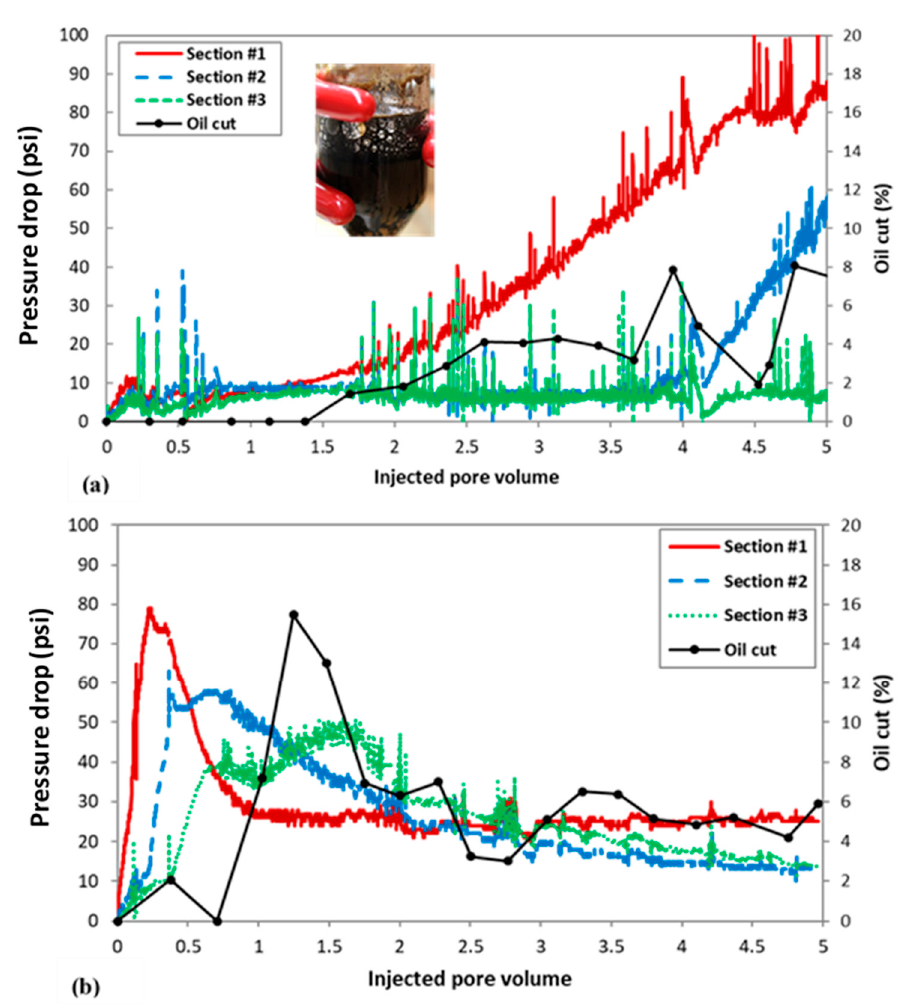
Figure 7. Higher oil cut and higher pressure at different sections of rock sample showed the better performance of PEF compared to that of foam. ( a ) CO 2 foam and ( b ) CO 2 PEF. The length of sections #1, #2 and #3 are 5 cm (see Figure 3a).